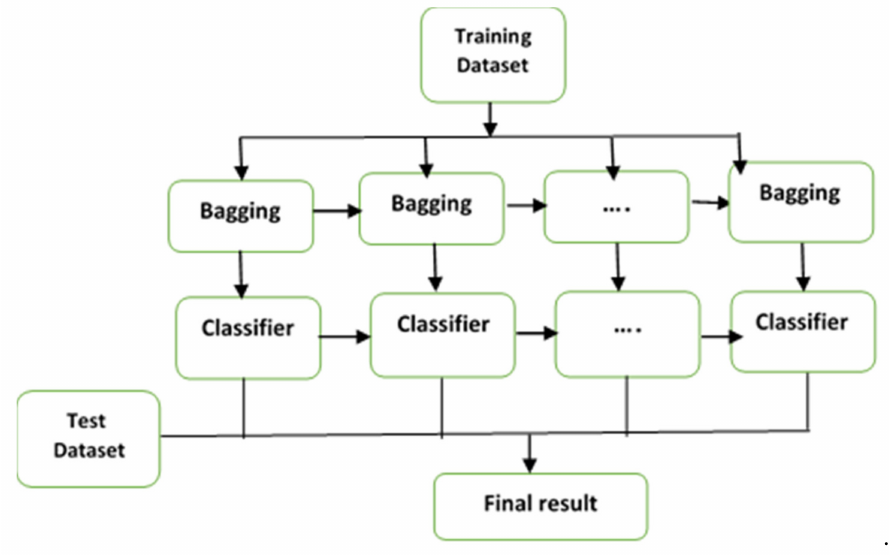
Figure 2. The gradient boosting framework.